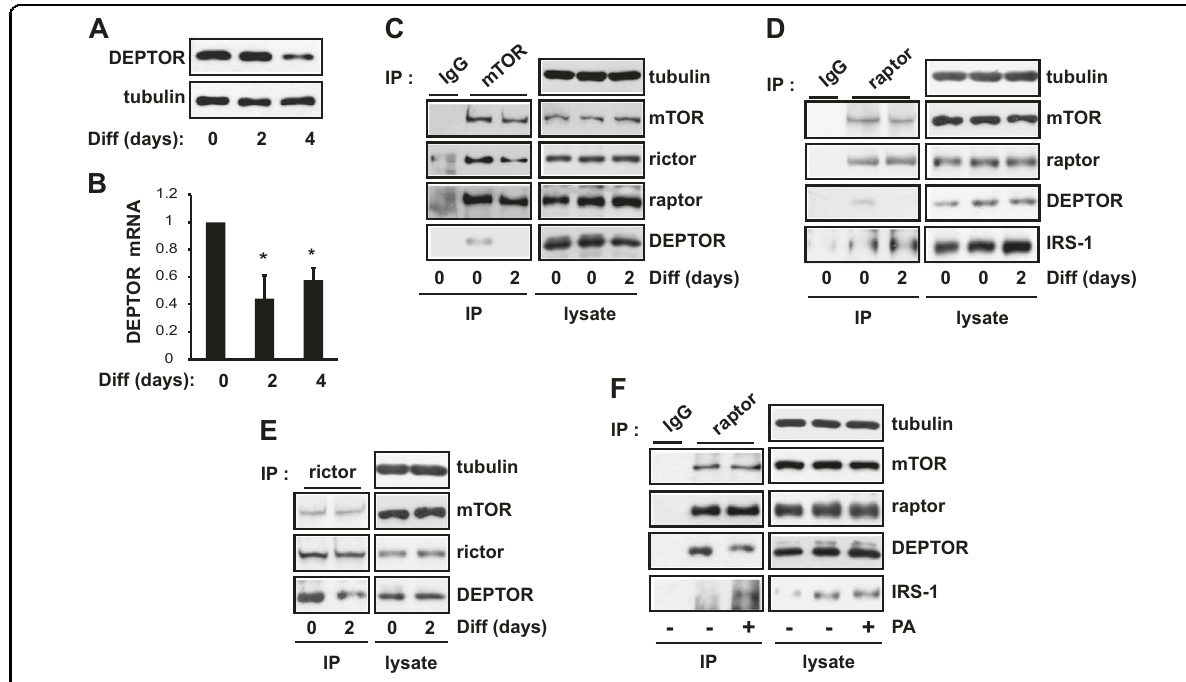
Fig. 3 DEPTOR displacement from mTORC1 increases the association between raptor and IRS-1. a , b Human endometrial stromal (hES) cells were induced to differentiate for 4 days in the presence of 0.5 mM 8-Br-cAMP. On day 0, 2, or 4 of differentiation, the cells were lysed and subjected to western blotting ( a ) and quantitative RT-PCR ( b ) to analyze DEPTOR expression. Human GAPDH was used to normalize gene expression. c On day 0 or 2 of differentiation, hES cells were lysed, subjected to immunoprecipitation against mTOR, and analyzed by western blotting. d , e Cells were treated as in ( c ), lysed, subjected to immunoprecipitation against either raptor ( d ) or rictor ( e) , and then analyzed by western blotting. f Cells were treated with 300 μ M C8-PA for 30 min, lysed, subjected to immunoprecipitation against raptor, and analyzed by western blotting. All data are shown as the mean ± SD or are blots representative of three to fi ve independent experiments. Student ’ s t -tests were performed to compare the indicated pairs of data. * P <